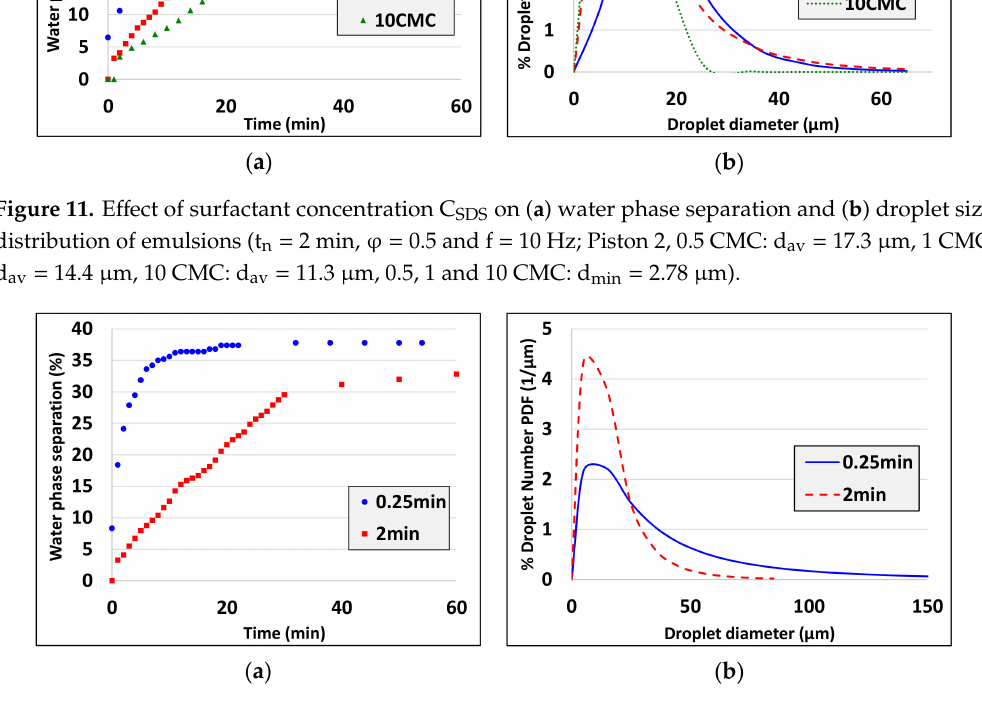
Figure 12. E ff ect of nominal emulsification time t n on ( a ) water phase separation and ( b ) droplet size distribution of emulsions (C SDS = 1 CMC, ϕ = 0.5 and f = 10 Hz; Piston 2, 0.25 min: d av = 29.2 µ m, 2 min: d av = 14.4 µ m, 0.5 and 2 min: d min = 2.78 µ